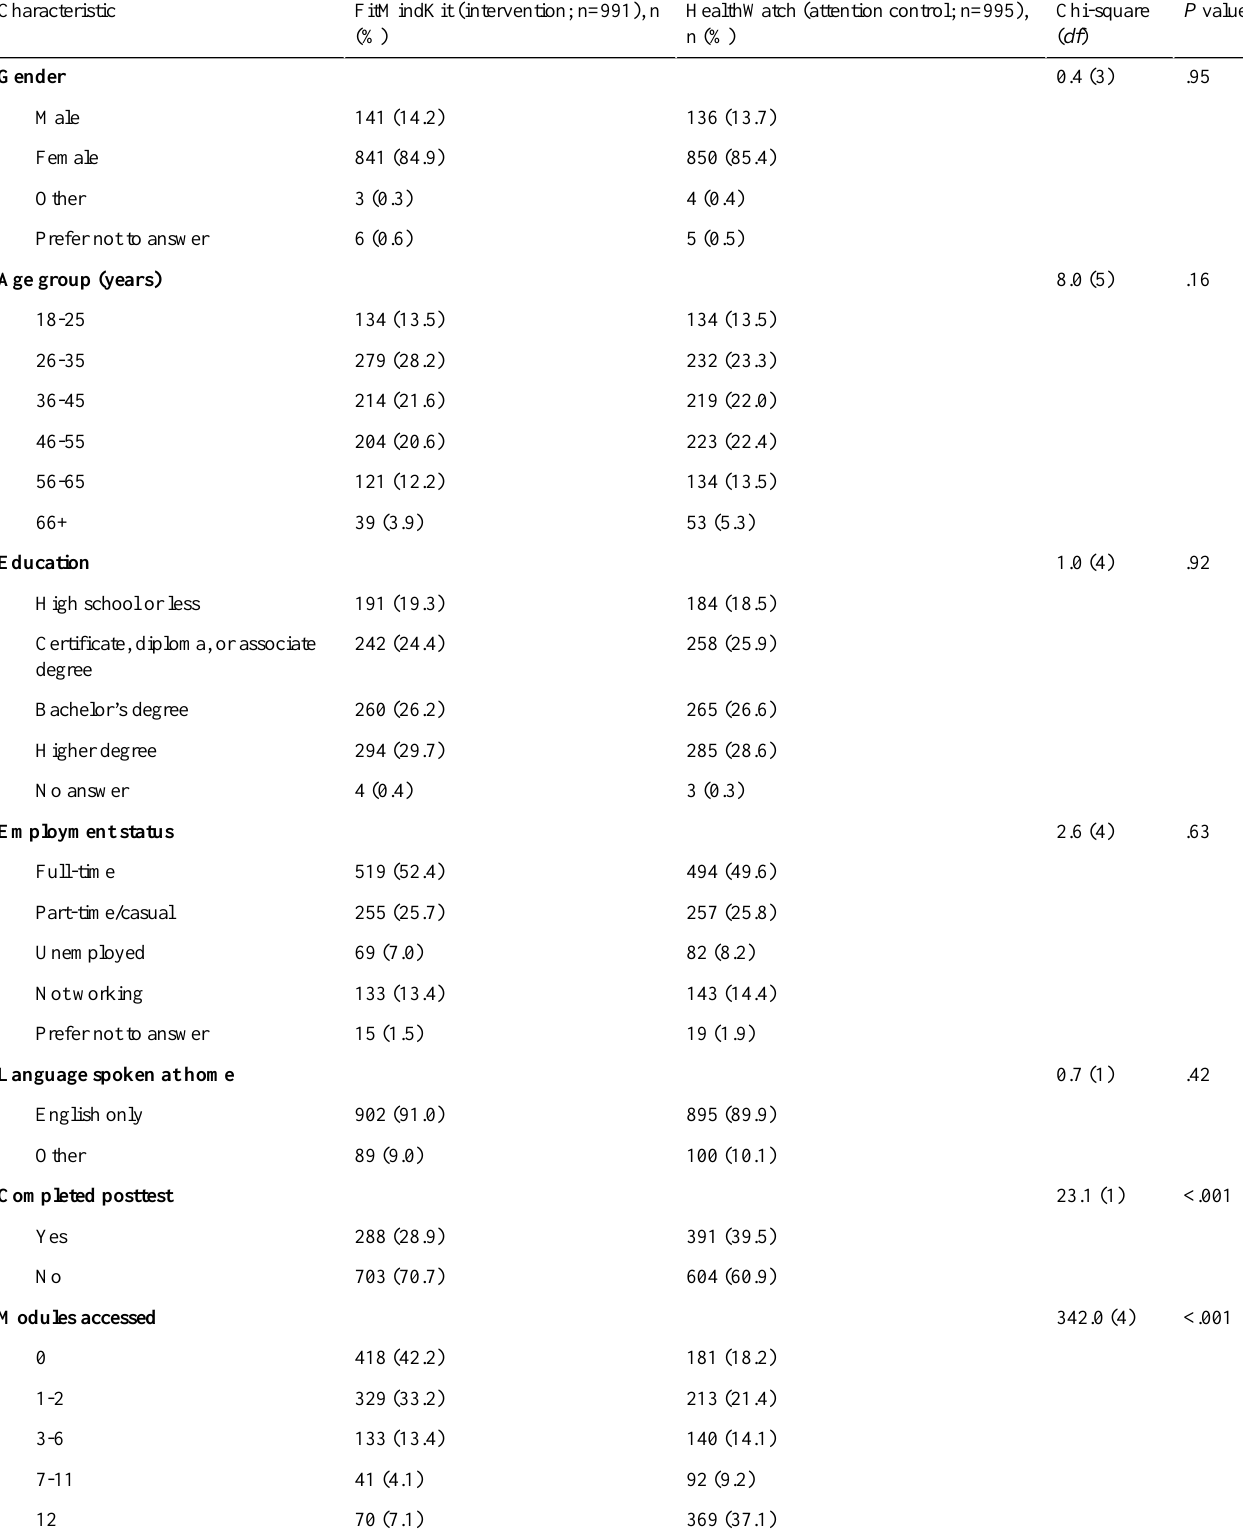
Table 1. Sample characteristics based on condition.